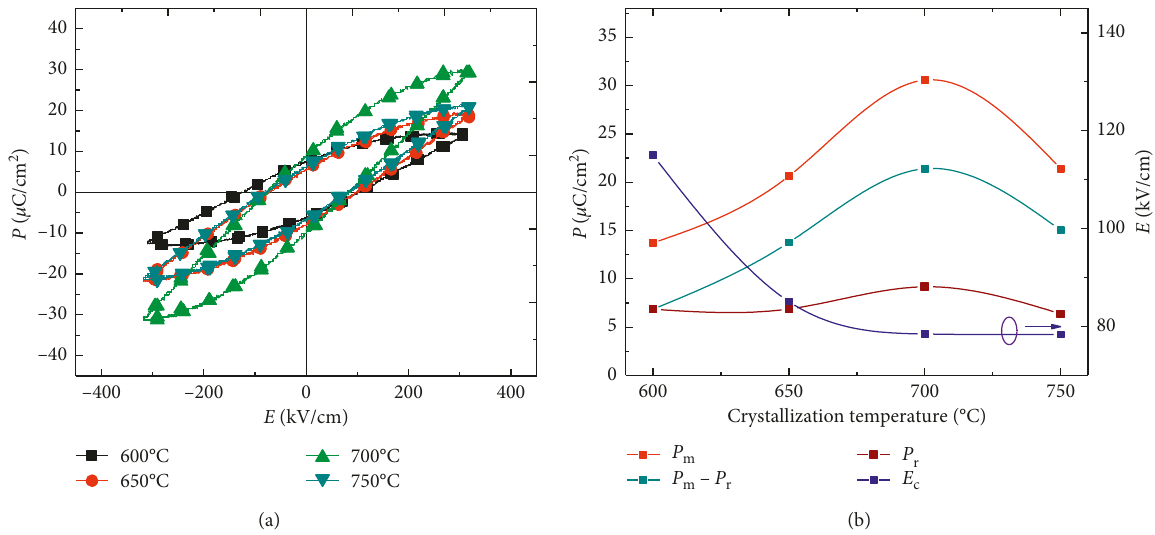
Figure 4: (a) P – E ferroelectric hysteresis loops of BNKT films at the same applied electric field of 300kV/cm and (b) the maximum polarization ( P m ), remnant polarization ( P r ), difference between P m and P r ( P m − P r ), and coercive field E c for BNKT